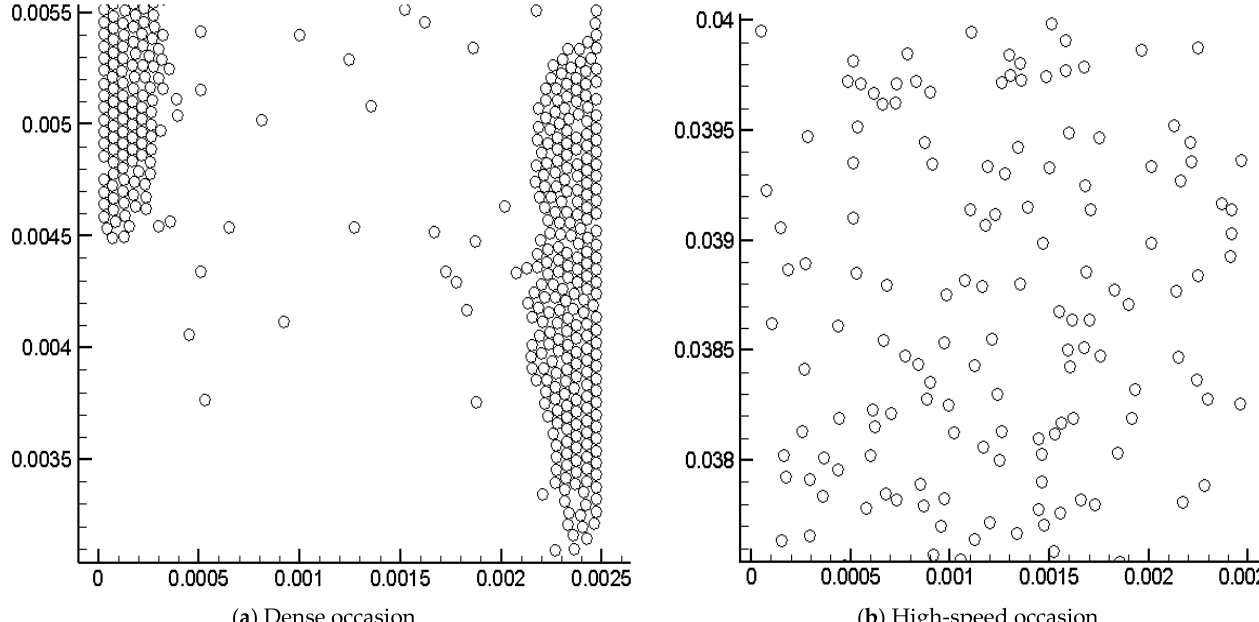
Figure 4. Sectional particle distributions without excessive overlapping.